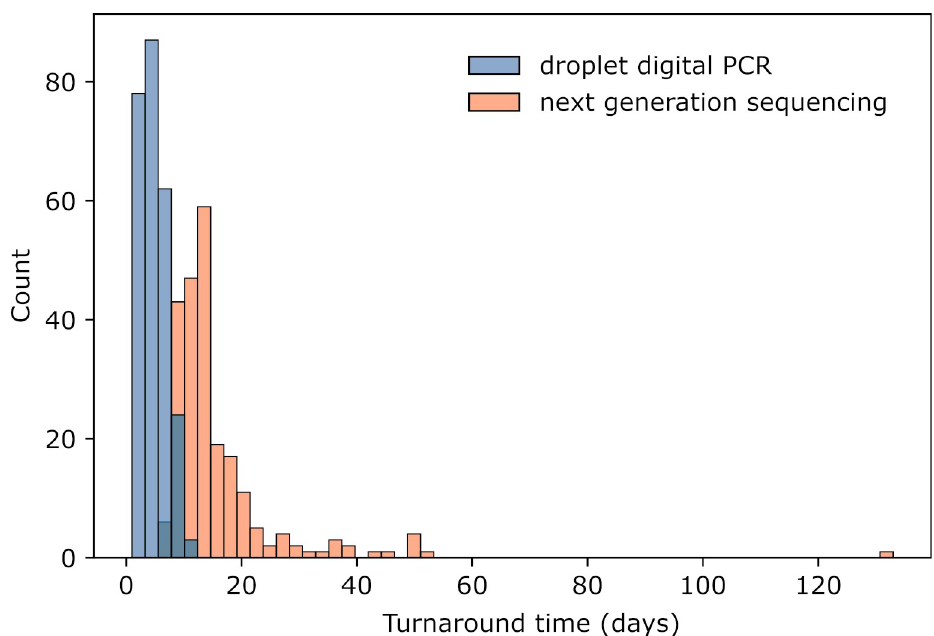
Fig 6. Histogram of turnaround times for droplet digital PCR compared to panel next generation sequencing.